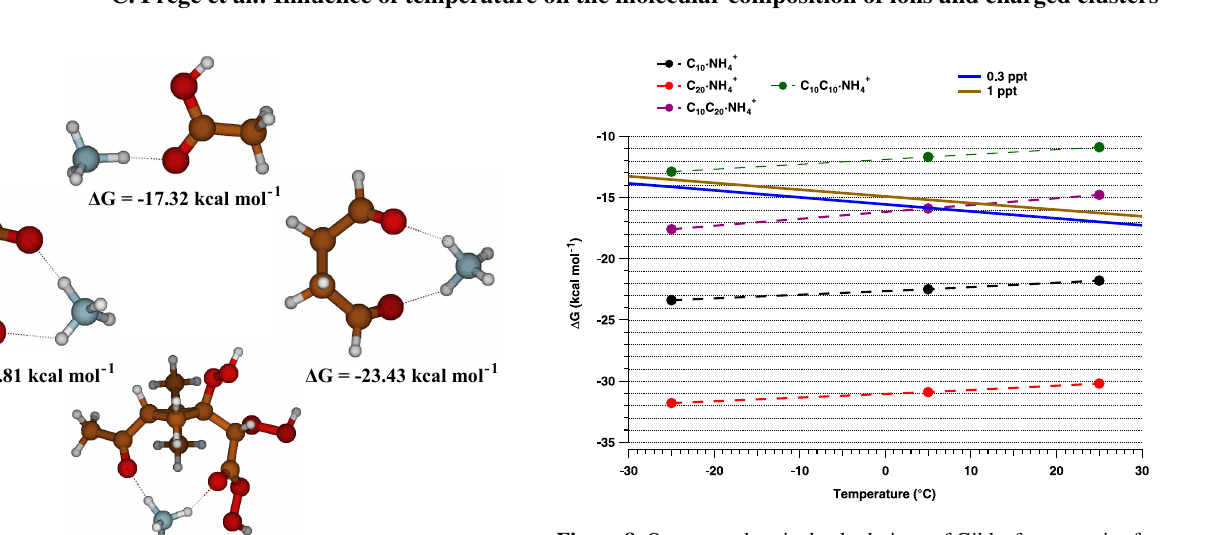
Figure 8. Quantum chemical calculations of Gibbs free energies for cluster formation at − 25, 5 and 25 ◦ C. Solid lines represent the re- quired (cid:49)G for equilibrium between evaporation and collision rates at 0.3 and 1pptv of the HOM mixing ratio, respectively. Markers show the (cid:49)G for each cluster (organic core clustered with NH + ) 4 at the three temperatures. C 10 · NH + (black circles) represent the 4 monomer, C 20 · NH + (red circles) represent the covalently bound 4 dimer, C 10 C 10 · NH + (green circles) represent the dimer formed by 4 the clustering of two monomers and C 10 C 20 · NH + (purple circles) 4 denote the preferential pathway for the trimer cluster (see Table